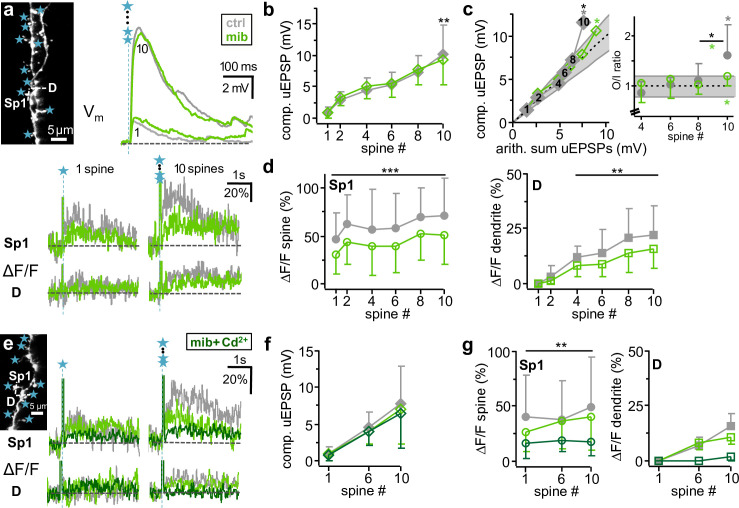
Molecular mechanisms of subthreshold integration: Low- and high-voltage-activated Cavs.a: Example low-voltage-activated Cav blockade experiment. Top left: Stimulated spine set with line scan sites Sp1, D, and uncaging spots. Top right: Somatic Vm recording of uEPSP, below spine (Sp1) and dendrite (D) ΔF/F for 1 and 10 spines. Grey traces: control. Green traces: mib, 10 μM. b: Cumulative effect (n = 11 cells) of mib on somatic compound uEPSP amplitude upon activation of 1, 2, 4, 6, 8, and 10 spines. Repeated measures 2-way ANOVA (see Materials and methods): interaction effect (spine # x mib) F(5,131) = 3.88, p = 0.010. Asterisks: significance of difference mib versus control. c: Cumulative effect (n = 8 cells) of LVA Cav blockade on averaged sO/I upon activation of 1–10 spines. Interaction effect (spine # × mib) F(4,69) = 4.69, p = 0.006. Lines as in Fig 1C. Black asterisks above error bars indicate significance of differences between mib and control. Gray and green asterisks/significance levels above error bars refer to O/I ratio distributions with means beyond the linear regime (0.8–1.2) tested against linearity (*p < 0.05, as in Fig 1C). Integration was significantly supralinear at 10 spines for both control and mib. The increase in O/I ratios between 8 and 10 spines was also significant but significantly smaller in mib versus control (inset *, Wilcoxon test). d: Effect of LVA Cav blockade on average ΔF/F in Sp1 (left, n = 26 spines in 11 cells) and D (right, n = 11) upon activation of 1–10 spines. No interaction effect on spine ΔF/F (spine # x mib): F(5,311) = 0.26, p = 0.933; mib effect: F(1,311) = 60.16, p < 0.001. No interaction effect on dendrite ΔF/F (spine # x mib): F(3,87) = 1.11, p = 0.359; mib effect: F(1,87) = 15.84, p = 0.003. Asterisks: significance of difference mib versus control. e: Example for subsequent blockade of low- and high-voltage-activated Cavs on ΔF/F in spine (Sp1) and dendrite (D) for 1 and 10 spines. Top left inset: Scan of stimulated spine set with indicated line scan sites Sp1, D and uncaging spots. Gray traces: Control. Green traces: mib (10 μM). Dark green: added Cd2+ (100 μM). f: Effect of subsequent low- and high-voltage-activated Cav blockade on somatic compound uEPSP amplitude upon activation of 1, 6, and 10 spines (n = 4 cells). g: Effect of subsequent low- and high-voltage-activated Cav blockade upon activation of 1, 6, and 10 spines on ΔF/F in Sp1 (left, n = 8 spines in 4 cells) and dendrite (right, n = 4). No interaction effect of Cd2+ wash-in after mib on spine ΔF/F (spine # × Cd2+): F(2,47) = 1.51, p = 0.254; Cd2+ effect: F(1,47) = 14.02, p = 0.007. Asterisks: significance of difference mib + Cd2+ versus mib only. arith., arithmetic; Cav, voltage-gated Ca2+ channel; LVA, low-voltage-activated; mib, mibefradil; O/I, output/input; uEPSP, uncaging-evoked excitatory postsynaptic potential.